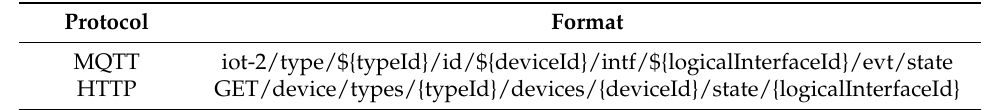
Table 5. Watson IoT resource request format.